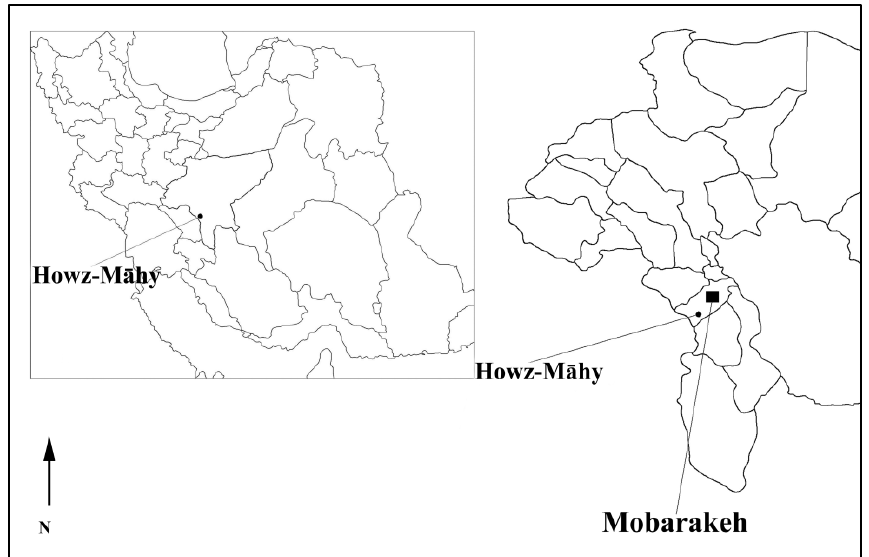
Figure 1. Location of Howz-Māhy in central